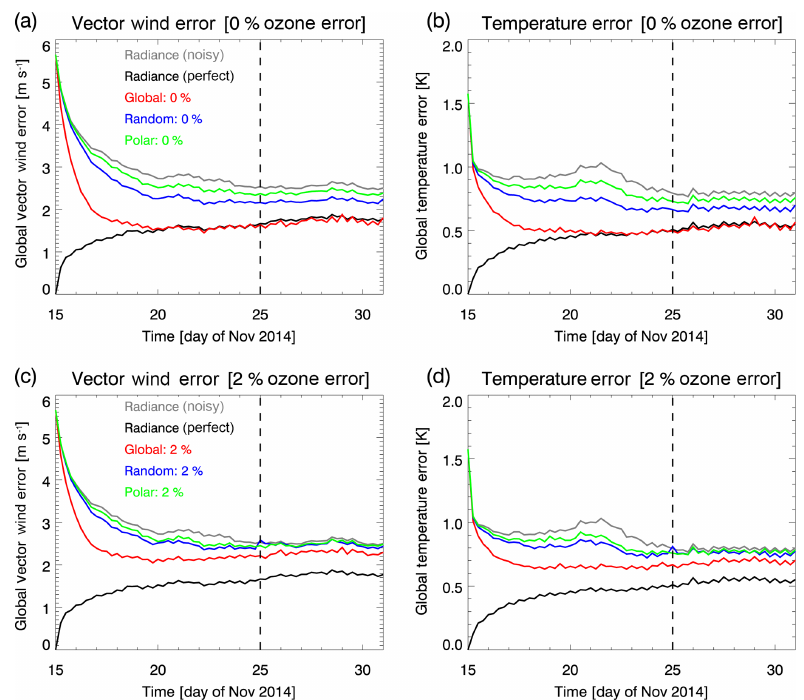
Figure 13. Globally and vertically (77 to 1.1hPa) averaged rms errors for five different cycling experiments from 15 November to 1 Decem- ber 2014, calculated every 6h. Black (grey) lines indicate experiments that assimilate perfect (noisy) radiance data only. Colored lines are for experiments that assimilate noisy radiance data along with global (red), random (blue), or polar-orbiting ozone data (green). Panels (a, c) show vector wind errors (ms − 1 ) for cases with perfect ozone (0% added noise) and noisy ozone (2% added noise), respectively. Panels (b, d) show temperature errors (K) for cases with perfect ozone and noisy ozone, respectively. Dashed lines indicate the end of the experimental spin-up phase. See Table 1, Sect. 5.1 and